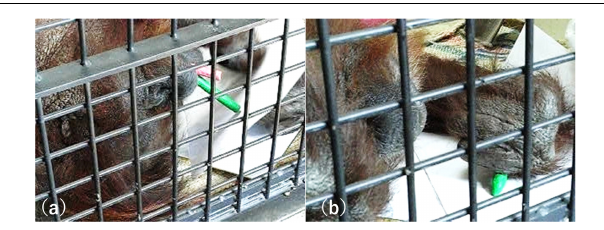
FIGURE 1 | (a) Molly is holding red and green crayons in her mouth and is preparing to draw. (b) Molly is also holding a green crayon in her left hand and is drawing on the